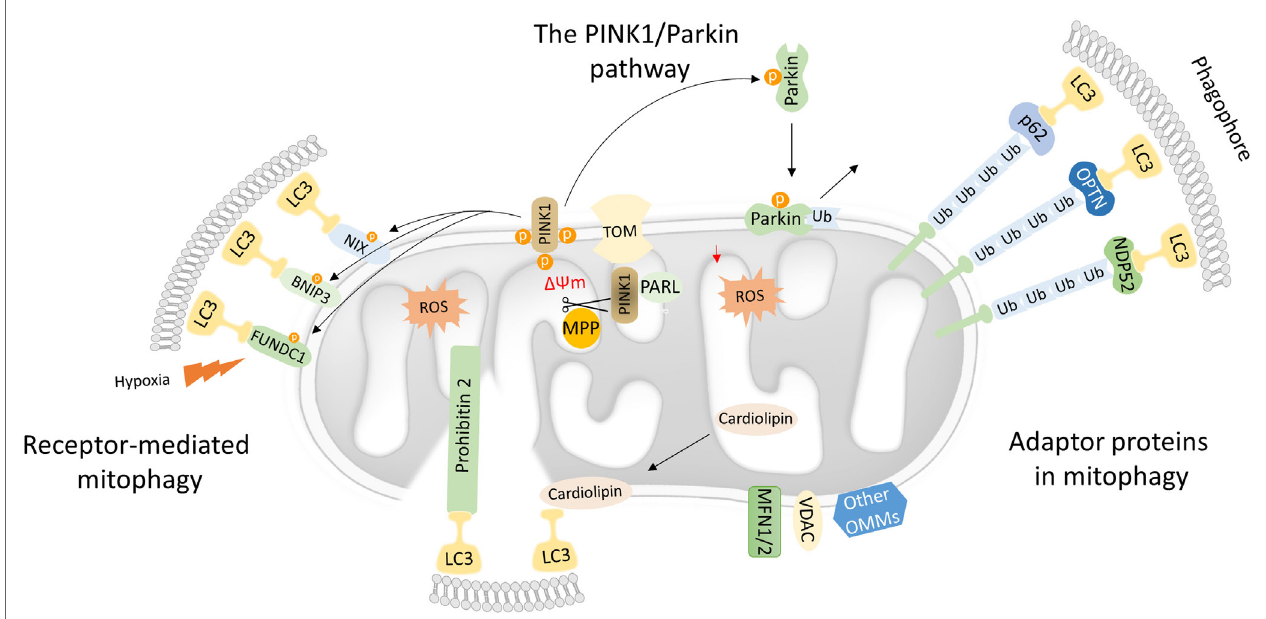
FiGURe 1 | Mechanistic insights into mitophagy process. Dysfunctional mitochondria redirect PTEN-induced kinase 1 (PINK1) to the OMM while its proteolytic cleavage through mitochondrial processing peptidase (MPP) and presenilin-associated rhomboid-like (PARL) proteases is blocked. Concomitantly, PINK1 recruits Parkin through a series of modifications, such as phosphorylation of both Parkin and ubiquitin. In turn, Parkin triggers the polyubiquitination of various OMM proteins including voltage-dependent-anion-selective channel 1 (VDAC1) and MFN1/2. Polyubiquitinated proteins are recognized by several adaptor molecules, including p62, optineurin (OPTN), and NDP52, promoting their recognition by light chain 3 (LC3) and autophogosomal formation. Receptor-mediated mitophagy relies on various OMM proteins such as BNIP3, NIX, and FUN14 domain-containing protein 1 (FUNDC1). In addition, PHB2 and cardiolipin serve as inner mitochondrial membrane receptors in response to mitochondrial damage. Subsequently, PHB2 and cardiolipin are exposed to the cytosol mediating LC3 recruitment via their LIR